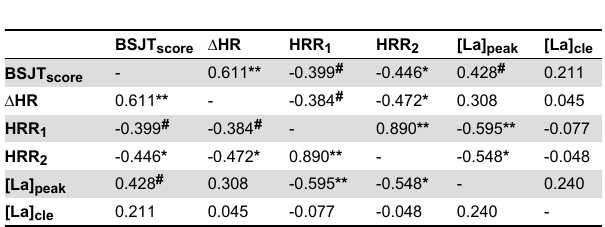
Table 3. Correlations between performance and physiological responses to exercise.